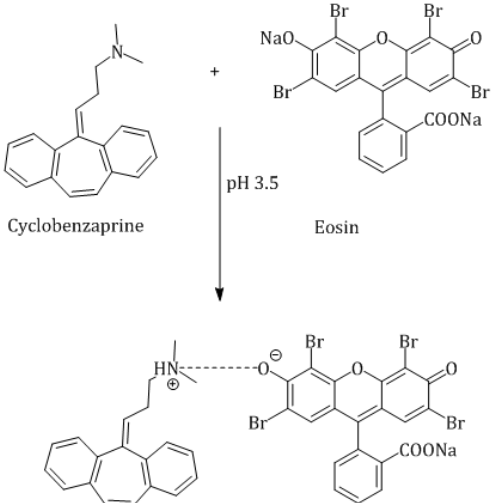
Figure 2: Association complex formation between cyclobenzaprine and eosin Y in the acidic medium.